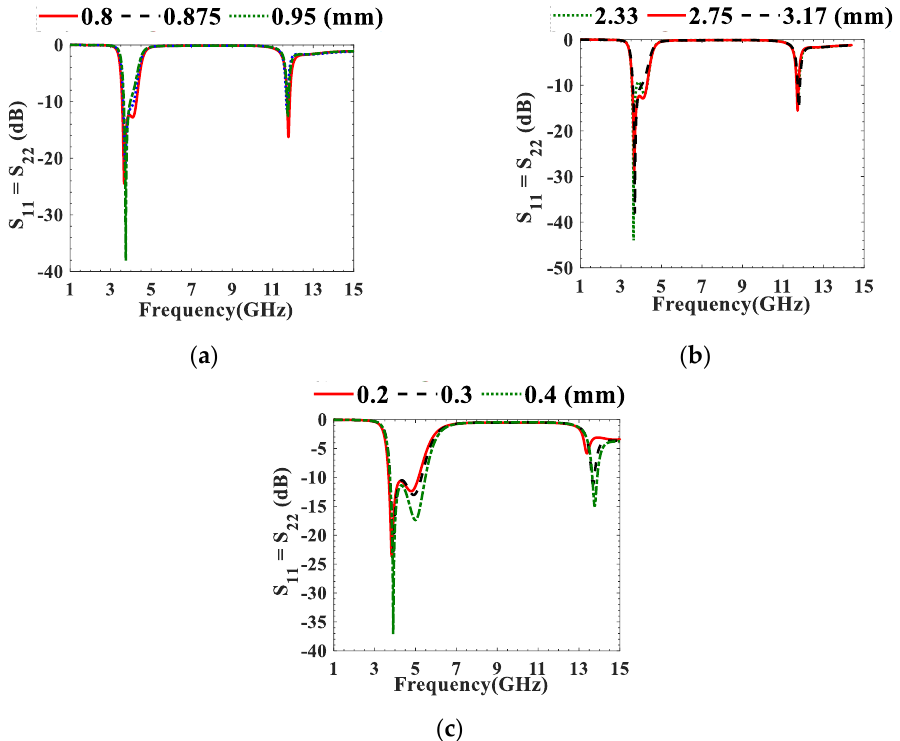
Figure 7. Parametric studies of the proposed NTL IBPF at (3.7 – 4.2 GHz) on (a) S , (b) L t , and (c) rvia